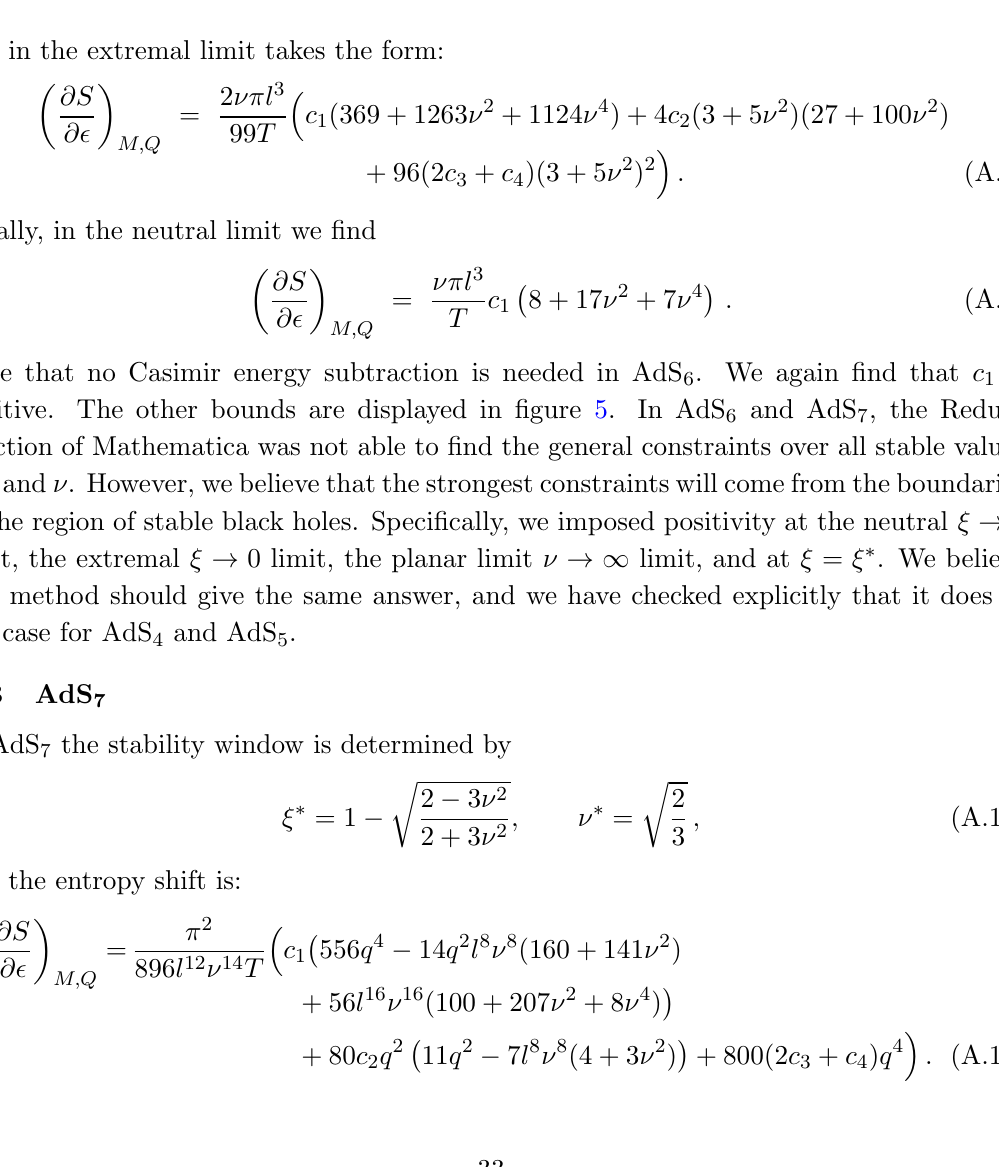
Figure 5 . Allowed regions for AdS 6 EFT